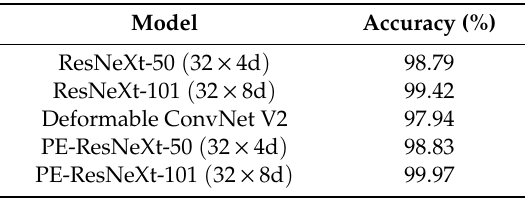
Table 3. Experimental results for PE-ResNeXt.